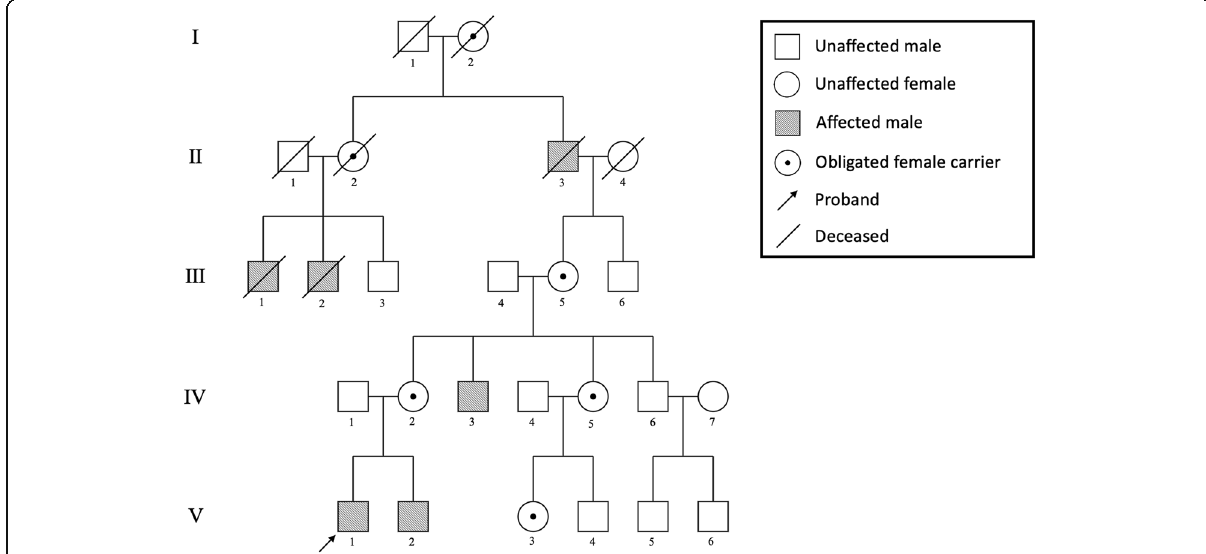
Fig. 1 Family pedigree of the Chinese family with short stature. Individuals include: males (squares), females (circles), deceased individuals (symbols with a crossing line), unaffected individuals (open symbol), affected individuals (slashed symbol), and X-linked carriers (denoted with a dot in the middle of